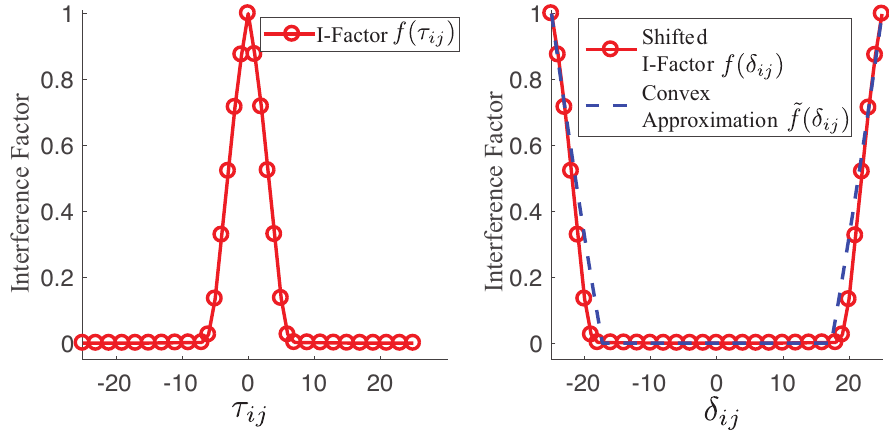
Figure 3. Interference factor ( left ) and its converted model as the convex function ( right